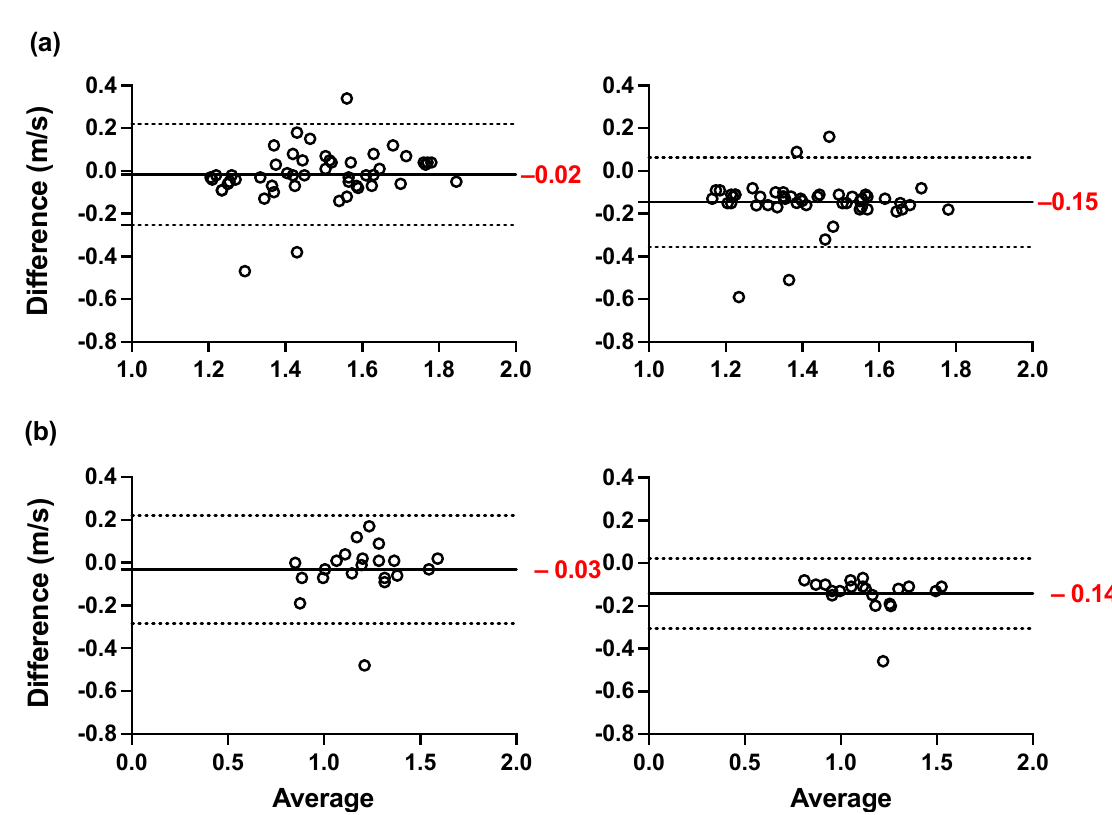
Figure 6. Agreement and Bland–Altman plots of the differences between the TEADRIP algorithm applied to the IMU- instrumented sock recordings and the stopwatch, and between the Mobility Lab system and the stopwatch in GS estimations for overground walking in ( a ) healthy and ( b ) participants. Table 3. Intersession reliability of the spatio-temporal parameters estimated by the TEADRIP algo- rithm applied to the IMU-instrumented sock and those estimated by the Mobility Lab system for overground walking. Intra Class Correlation Coefficient (ICCs) and their 95% CI for the 10MWT.